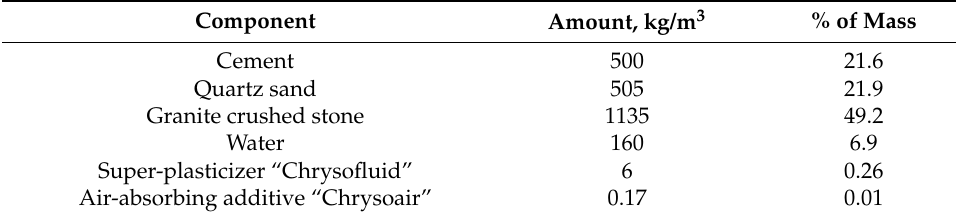
Table 1. Mixing composition of the concrete.